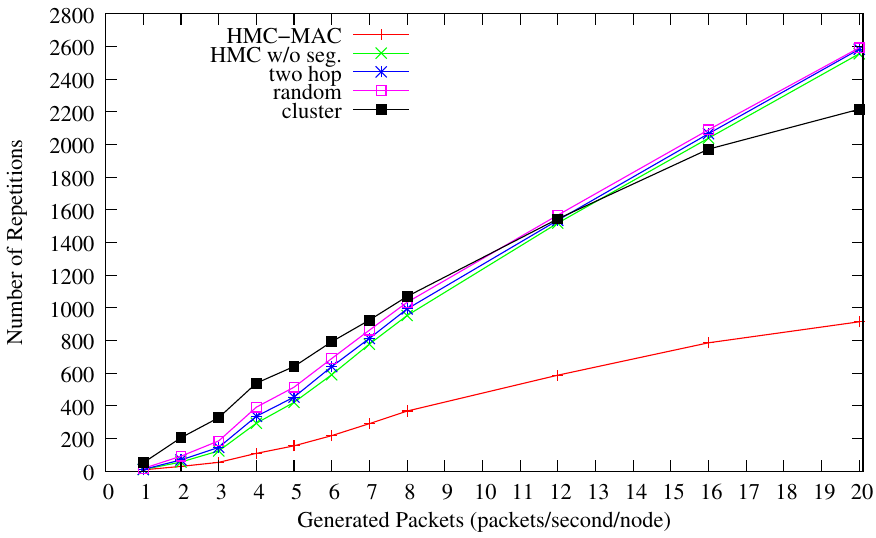
Figure 14. Number of repetitions for burst traffic.